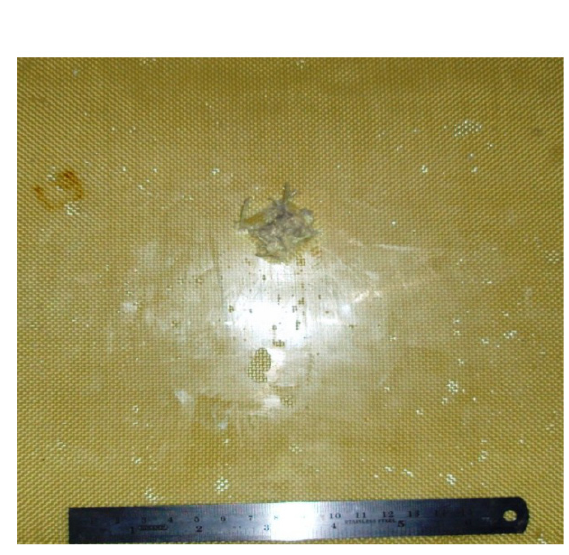
Figure 5. Damage at rear face of 0/90, 19 layer laminate. Figure 6. Damage on rear face of 0/90/30/-60, 19 layer